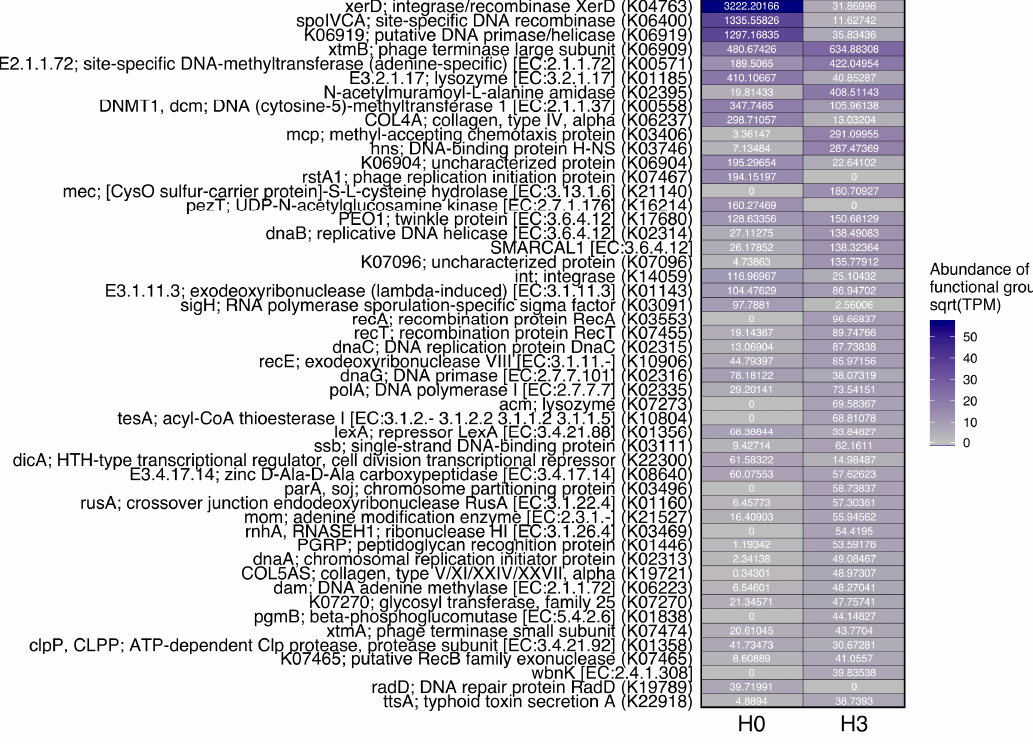
Figure 4. Viral genes heatmap generated with VIBRANT.